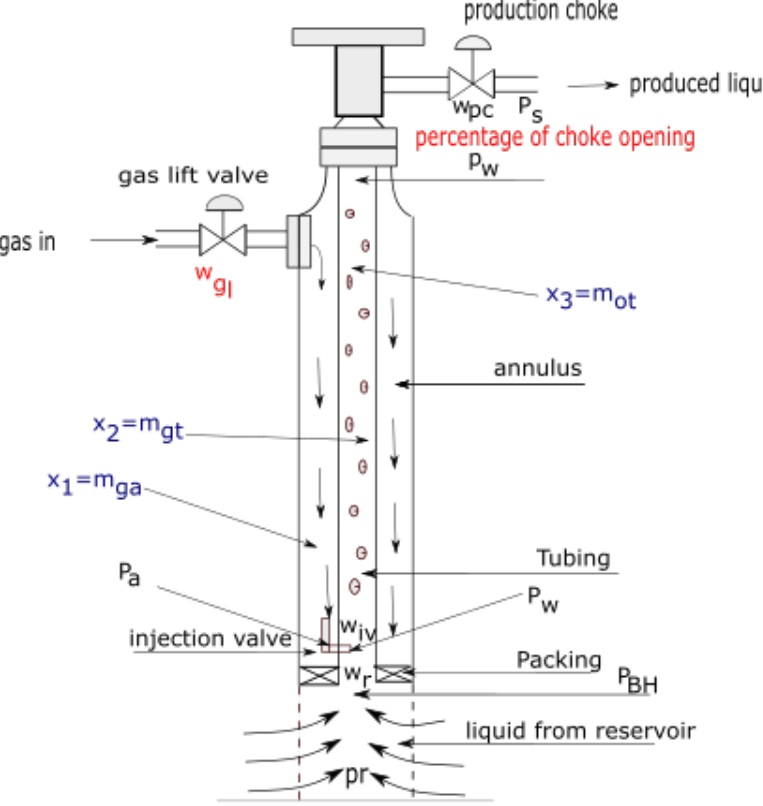
Figure 1. A gas-lifted system showing the states and key algebraic variables. Gas is delivered from the surface compressor station to the system through the gas-lifted valve, and the produced mixture is removed from the volume through the production choke. [Source: by